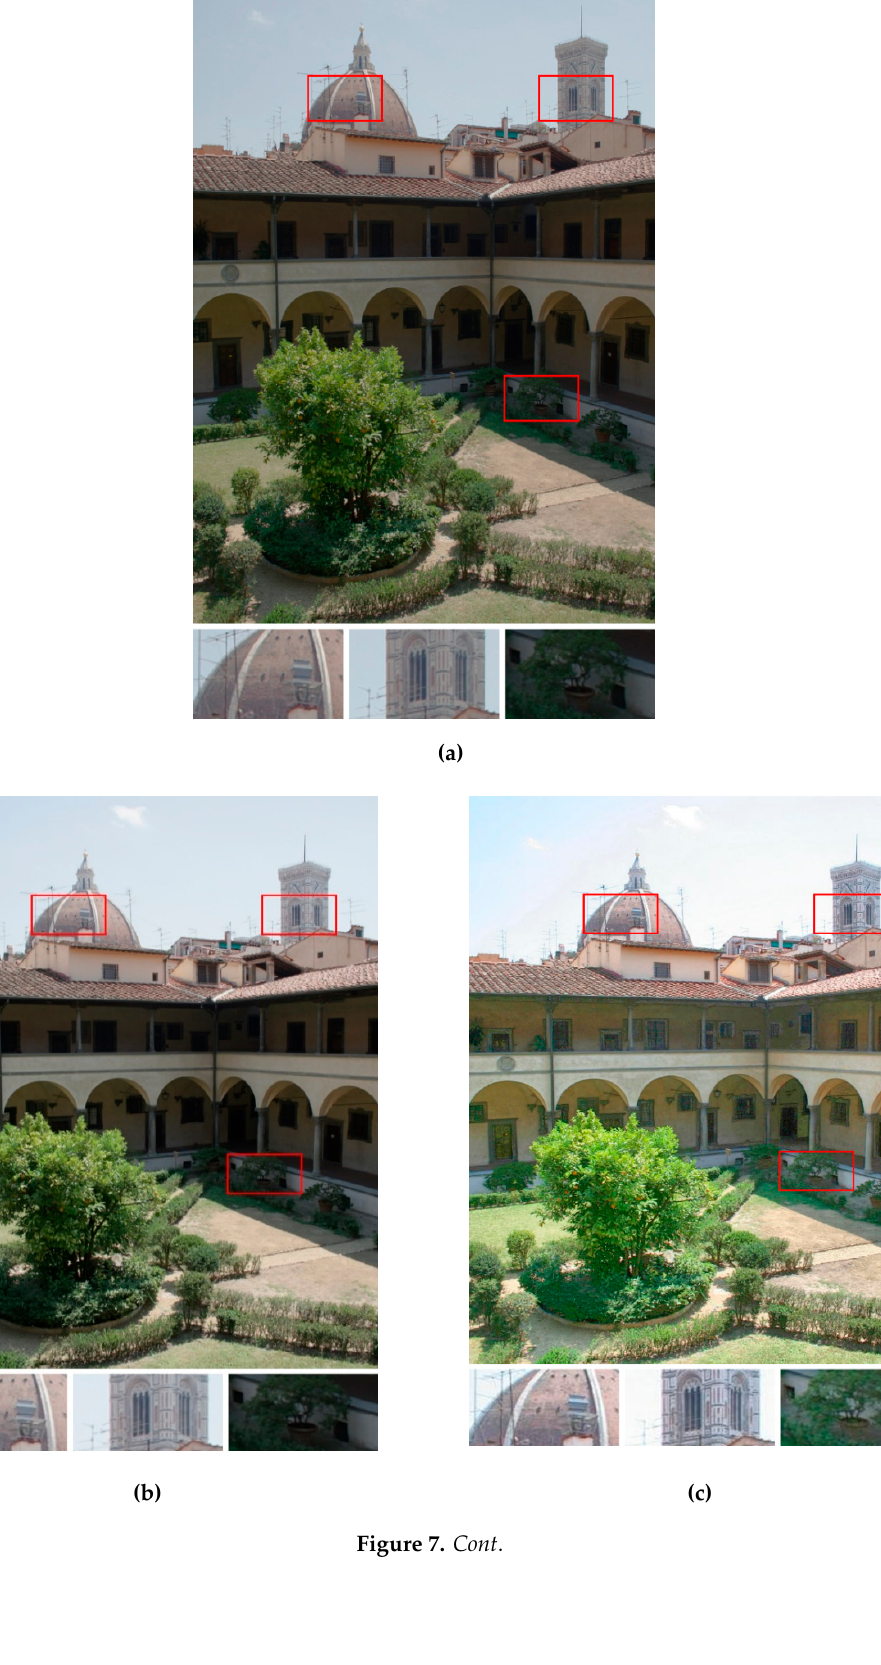
Figure 7 . Cont. Figure 7. Cont